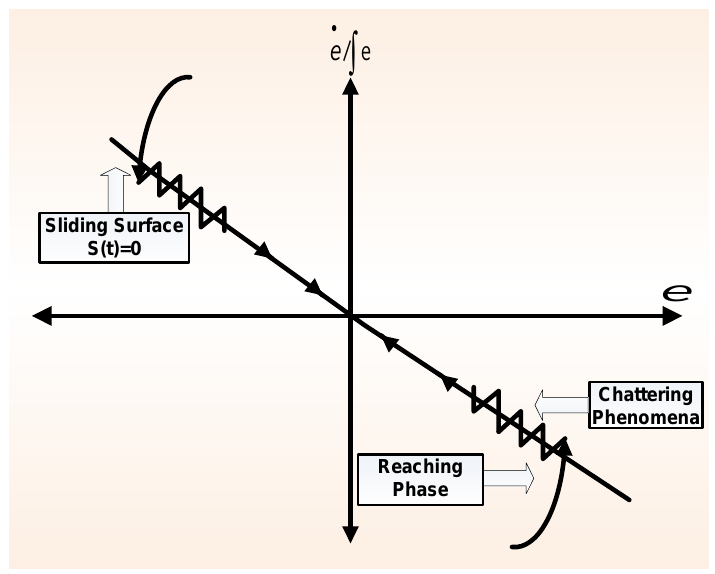
Figure 9. Graphical interpretation of the sliding mode controller.